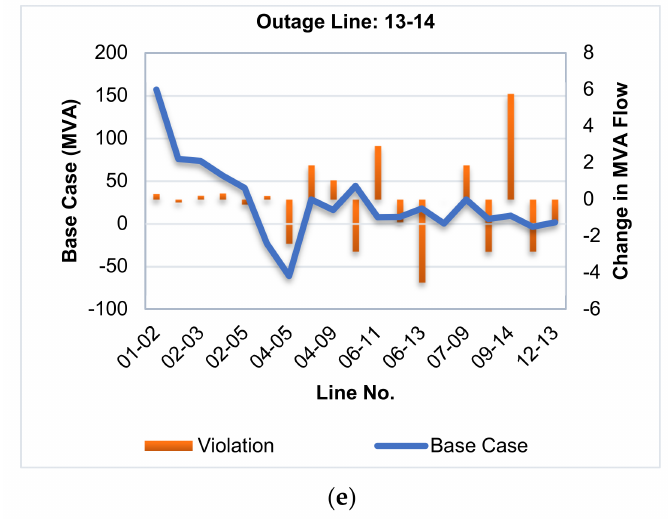
Figure 3. Different congestion scenarios in IEEE 14-bus System.